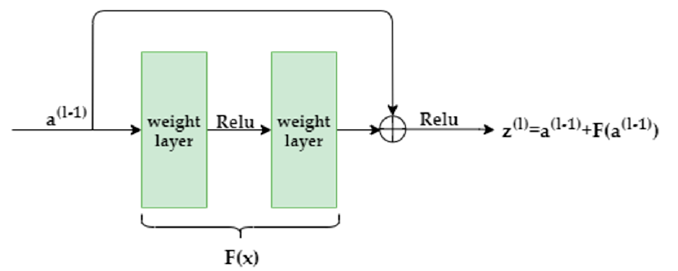
Figure 2. Residual block.